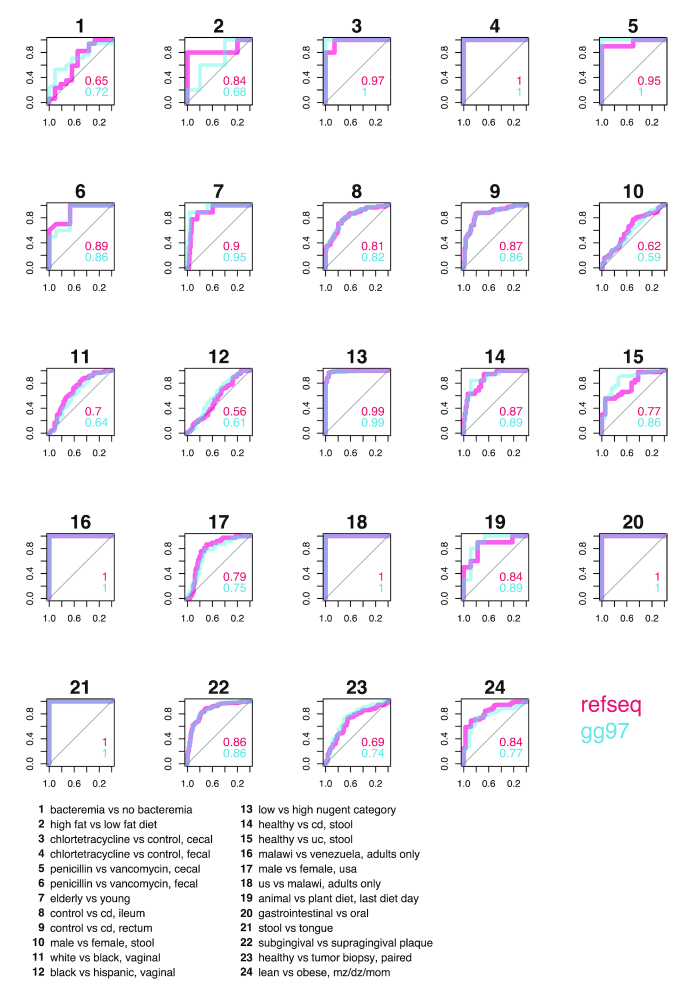
ROCs comparing NCBI RefSeq and Greengenes 97 (gg97) databases. Sweeping across 16s-based binary classification tasks available in ML Repo (24), we compare ROCs of random forest with genus-level taxonomic summaries as predictors from OTU-picking strategies with the NCBI RefSeq prokaryote reference database and the Greengenes 97 reference database. AUCs are listed within plots and are colored respective to each database. cd: Crohn's disease; dz: dizygotic; mz: monozygotic; uc: ulcerative colitis.